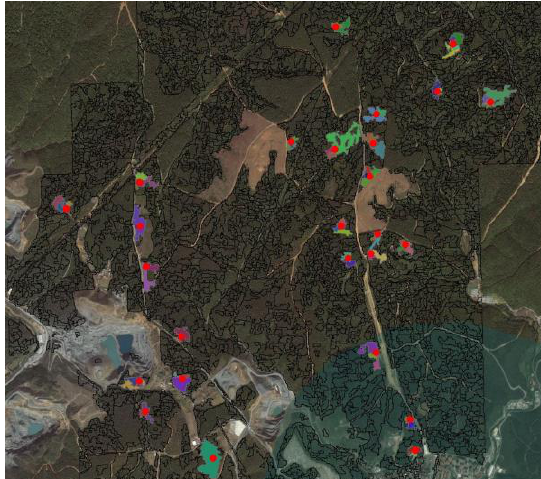
Fig.10. 26 Ground truthing areas overlaped on the